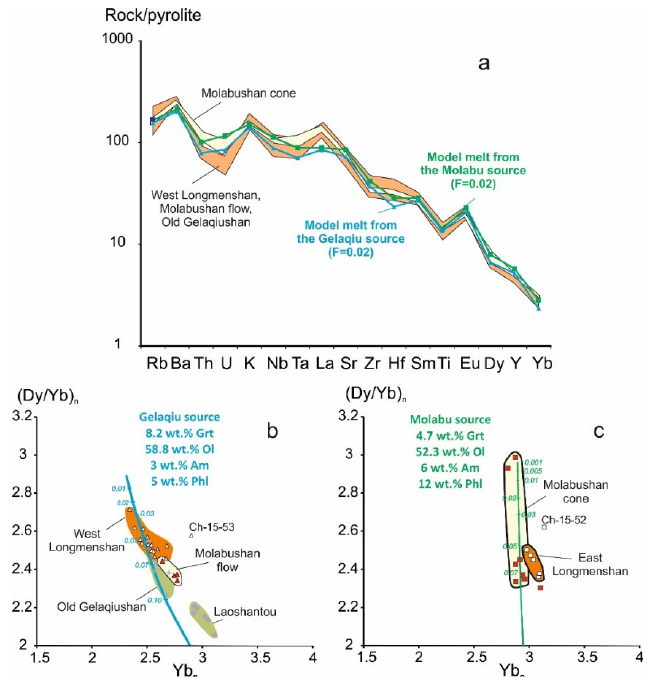
Figure 17. Results of trace-element modeling of equilibrium melting on the diagrams of normalized trace-element patterns ( a ) and (Dy/Yb) n versus Yb n ( b , c ). Symbols are as in Figure 5. Abbreviations: Ol—olivine, Opx—orthopyroxene, Cpx—clinopyroxene, Phl—phlogopite, Am—amphibole, Ap—apatite. In the Gelaqiu and Molabu model sources, variable proportions of minerals, indicated on the diagrams (b,c), are complemented by a constant proportion of minerals: Opx 10 wt.%, Cpx 15 wt.%, Ap 0.03 wt.%. Numbers in italics indicate the degree of partial melting (F). Melting of moderate-Mg rocks from East Longmenshan and Laoshantou trachyandesites are not modeled because of later modifications. Pyrolite normalization is after Table 3. Compositions of model sources for Wudalianchi liquids (batch partial melting).